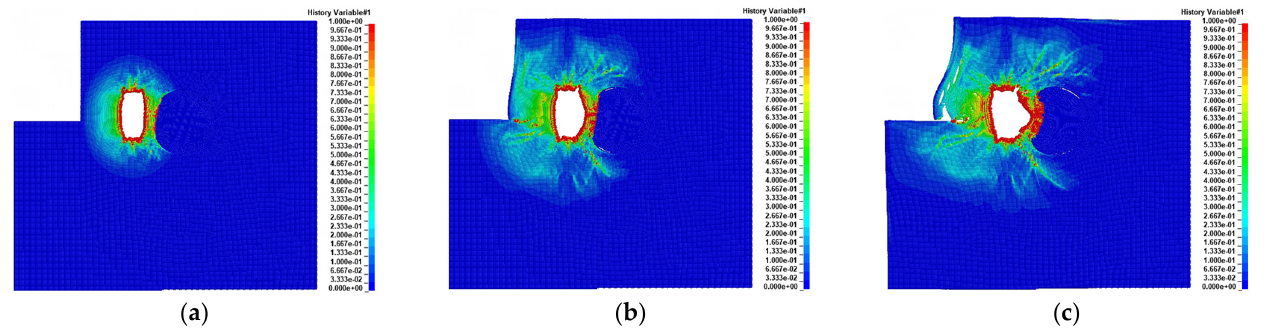
Figure 13. Rock-breaking effect under silt clay medium filling; ( a ) t = 2 × 10³ μ s; ( b ) t = 4 × 10³ μ s; ( c ) t = 8 × 10³ μ s.